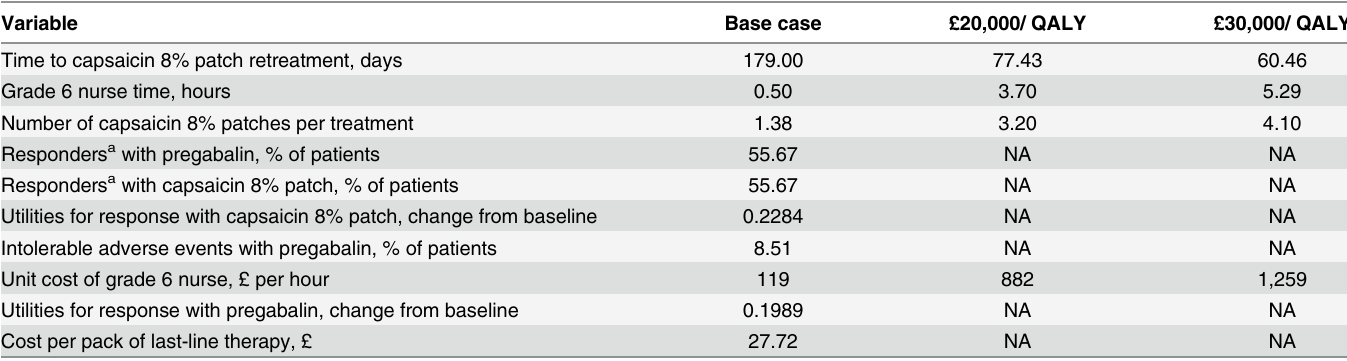
Table 5. Threshold